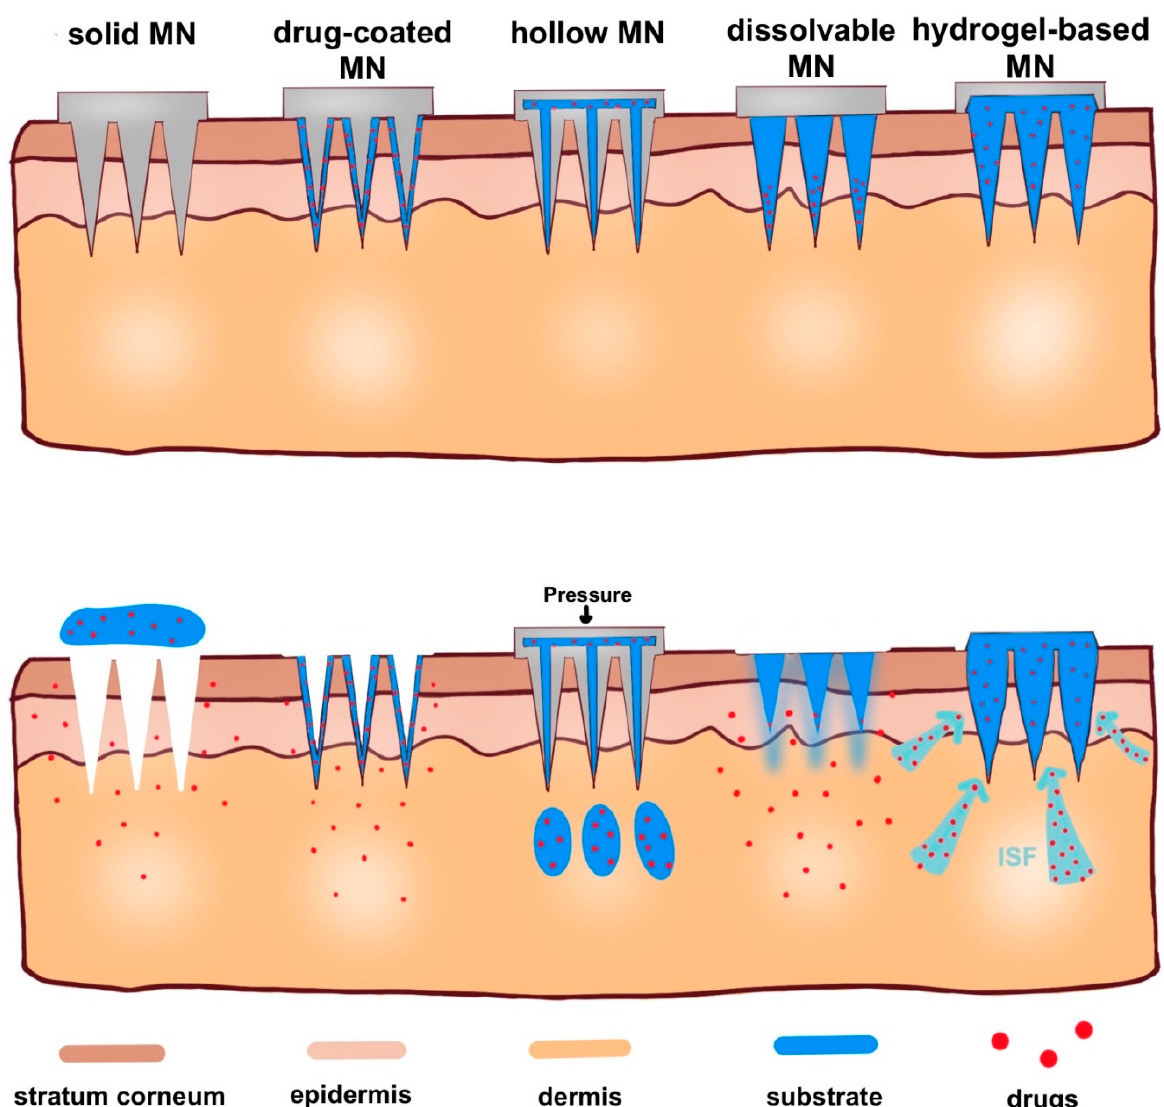
Figure 4. Schematic representation of five types of microneedle administration methods. Solid MNs are inserted into the skin and removed, leaving a channel through which the drug enters. Drug-coated MNs are the same as solid MN, except the drug is on the surface of the microneedles. For hollow MNs, after adding pressure, drug is released from the hollow microneedle. For dissolvable MN, when the microneedle substrate is dissolving, the drugs on the tip of the needle are released. When hydrogel-based MNs swell up from absorbing (ISF), the drug is released into the body.